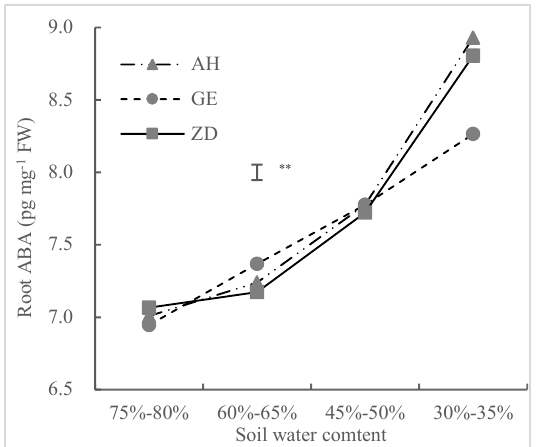
Figure 5. Interaction between soil water content (75 – 80%, 60 – 65%, 45 – 50%, and 30 – 35% of water- holding capacity) and cultivars (AH: Aohan; GE: Golden Empress; ZD: Zhaodong) on root abscisic acid (ABA) content of alfalfa. ** p < 0.01.